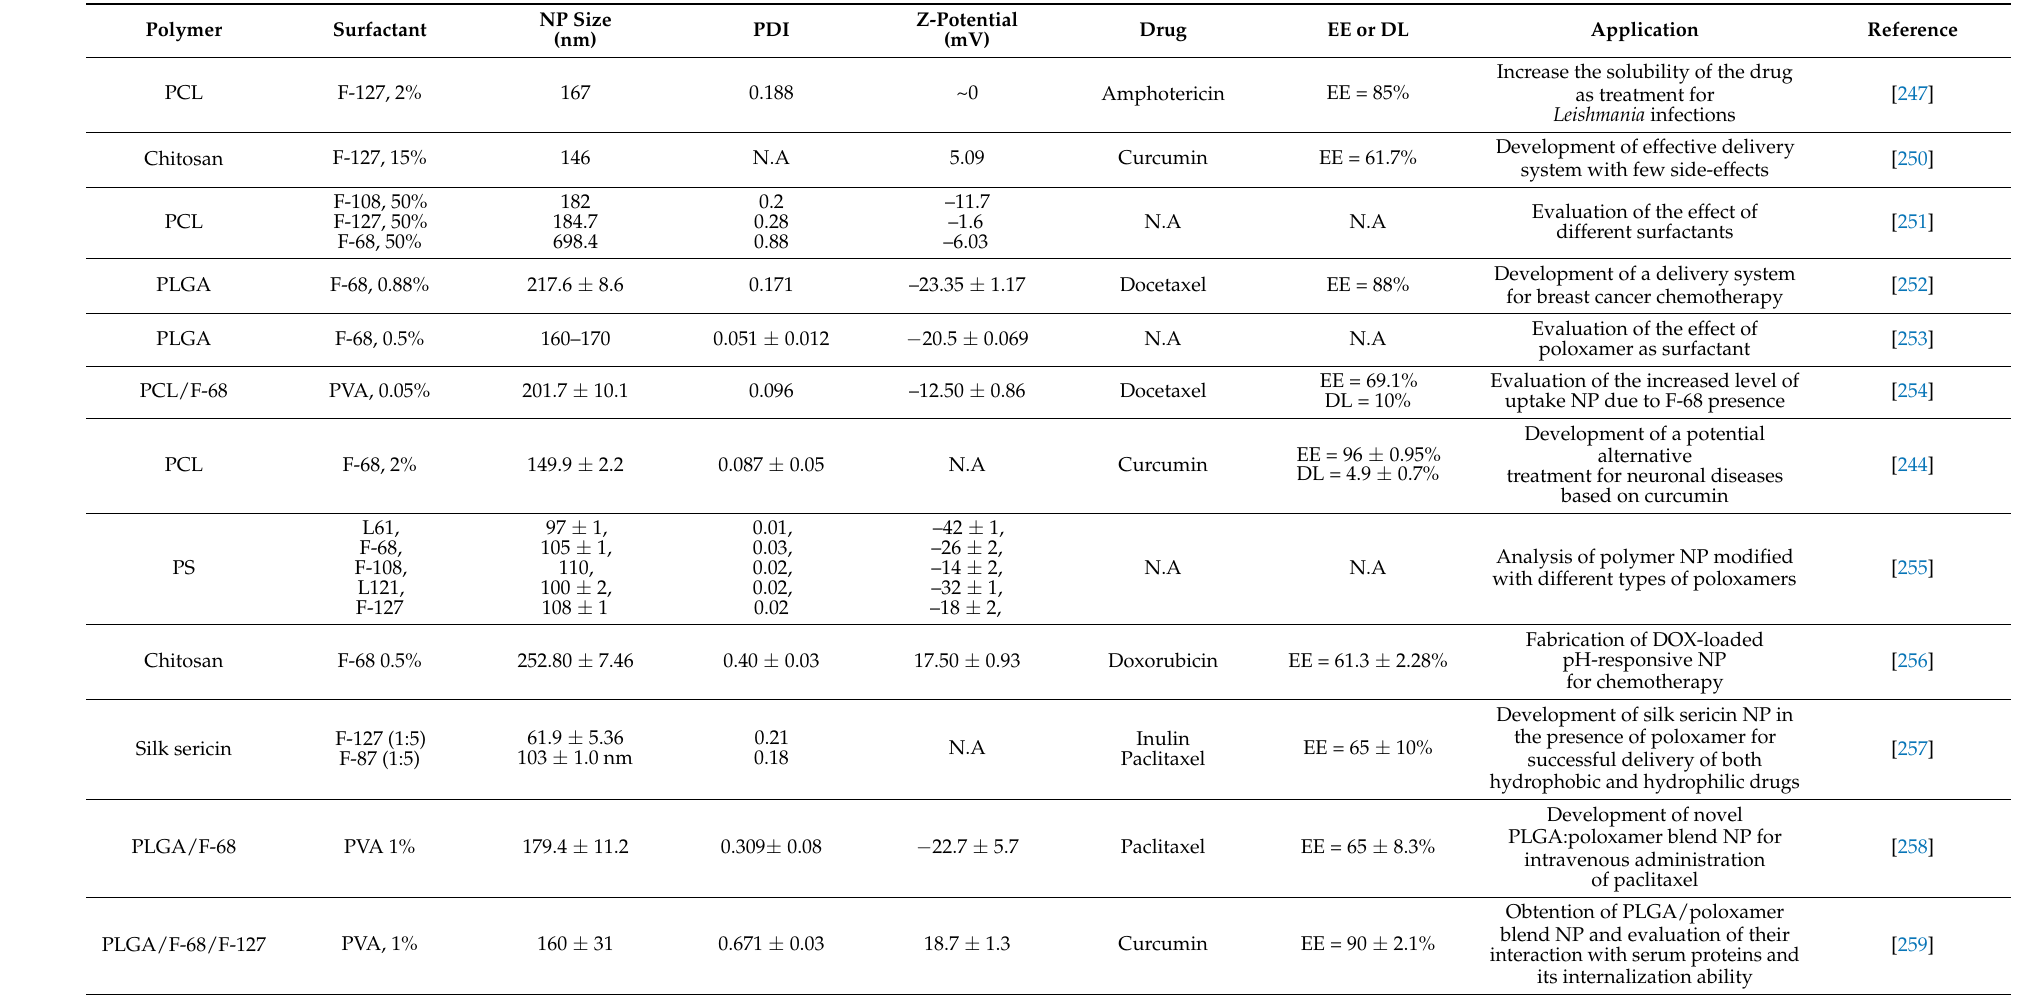
Table 4. Nanoparticulate formulations stabilized with